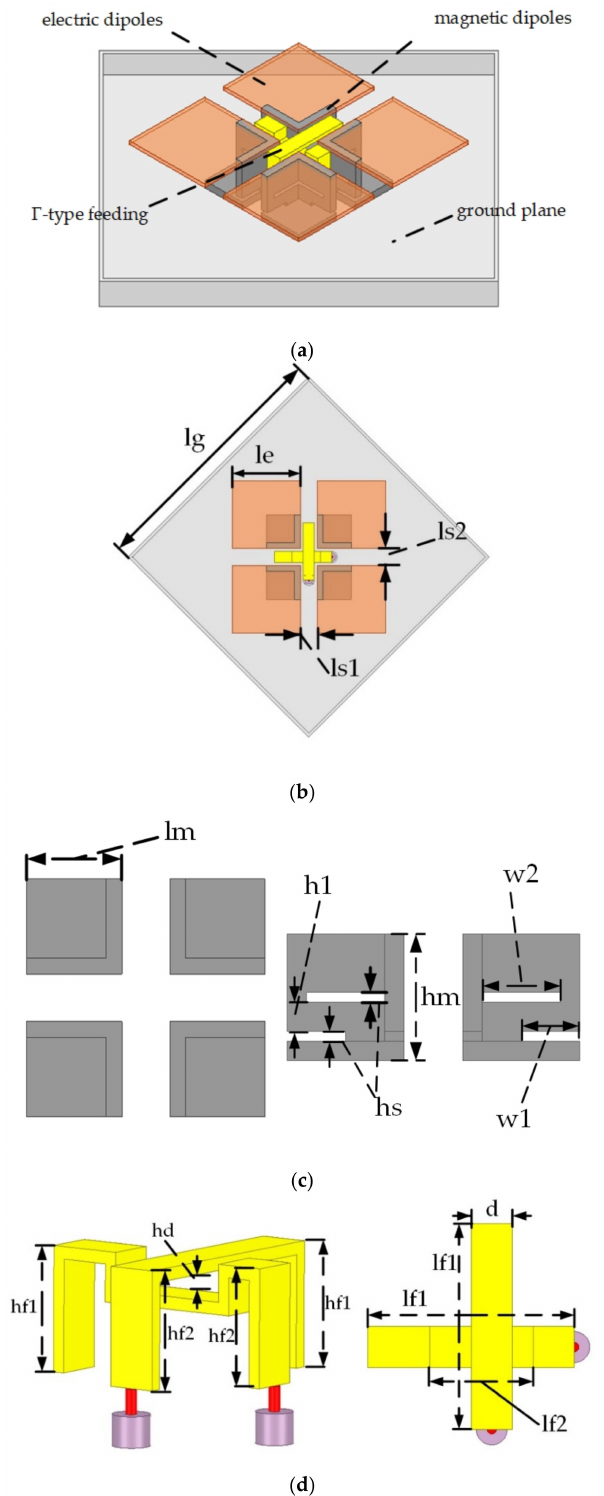
Figure 1. Antenna geometry: ( a ) configuration of the proposed MED; ( b ) top view of the proposed MED; ( c ) configuration of the proposed MED’s magnetic dipoles; ( d ) configuration of the proposed MED’s feeding